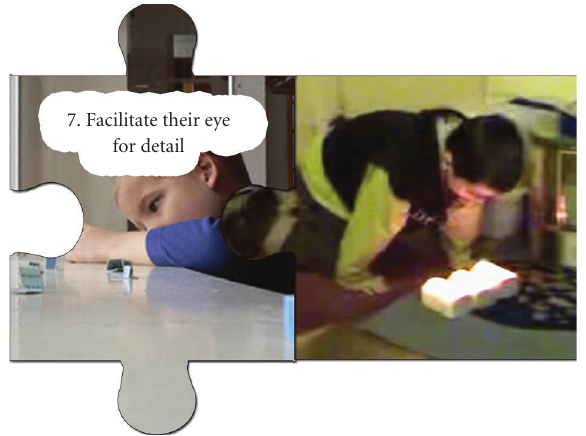
Figure 11: Eye for detail: (a) Beer investigates pieces of paper on the table. (b) Robbert counts five red lights on top of the blocks instead of the number of red blocks on the floor.